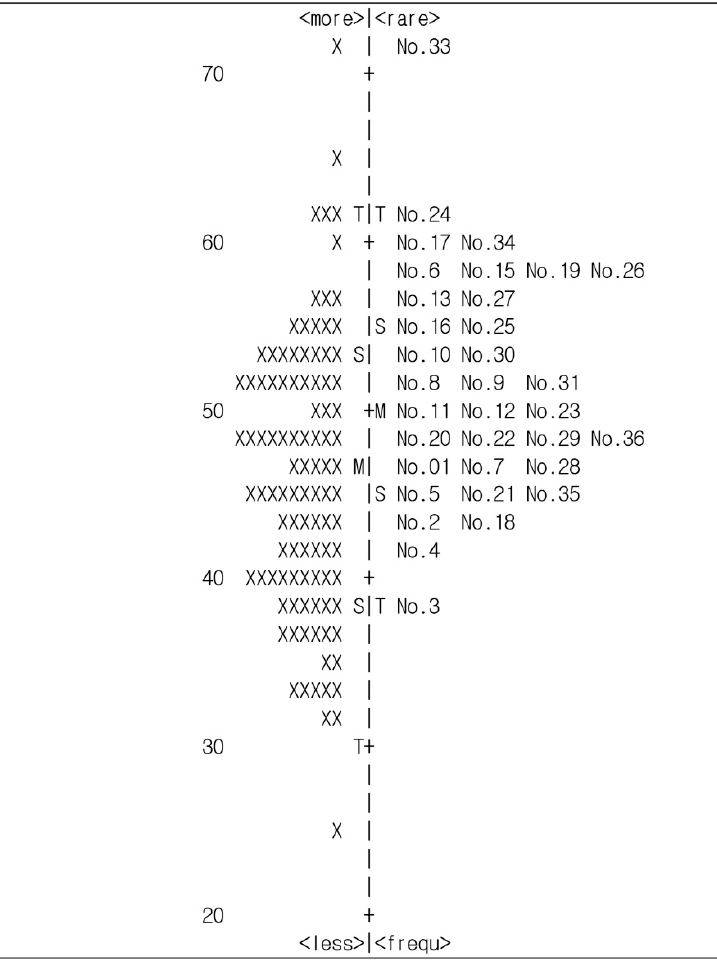
Figure 1. Item di ffi culty. (Notes: The left map is about person’s ability and the right map is about items’ di ffi culty. Abler persons and more di ffi cult items are placed on the top of the diagram. # = one persons, M = mean, S = 1 SD from the mean, and T = 2 SD from the mean.).